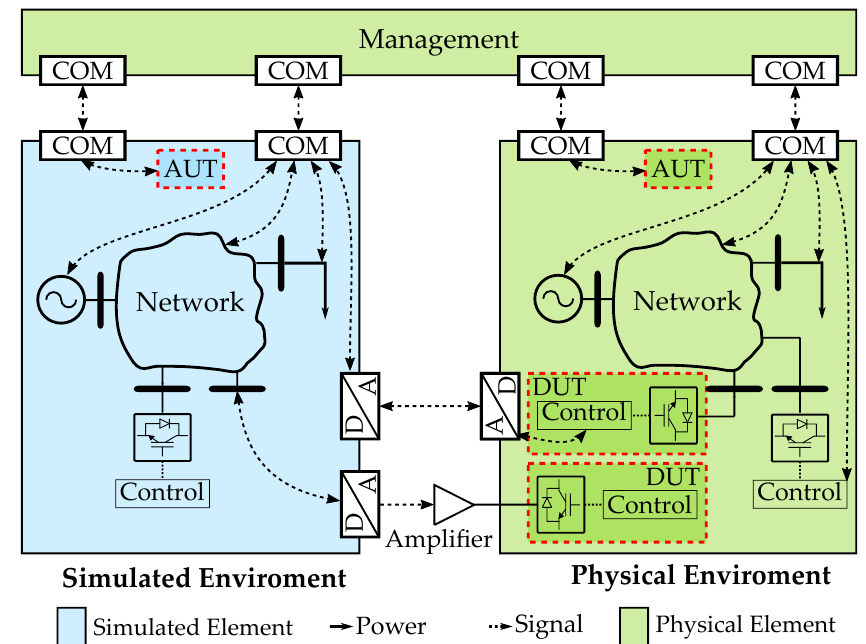
Figure 2. Generic scheme describing the Power System Hardware-in-the-Loop (PSHIL)